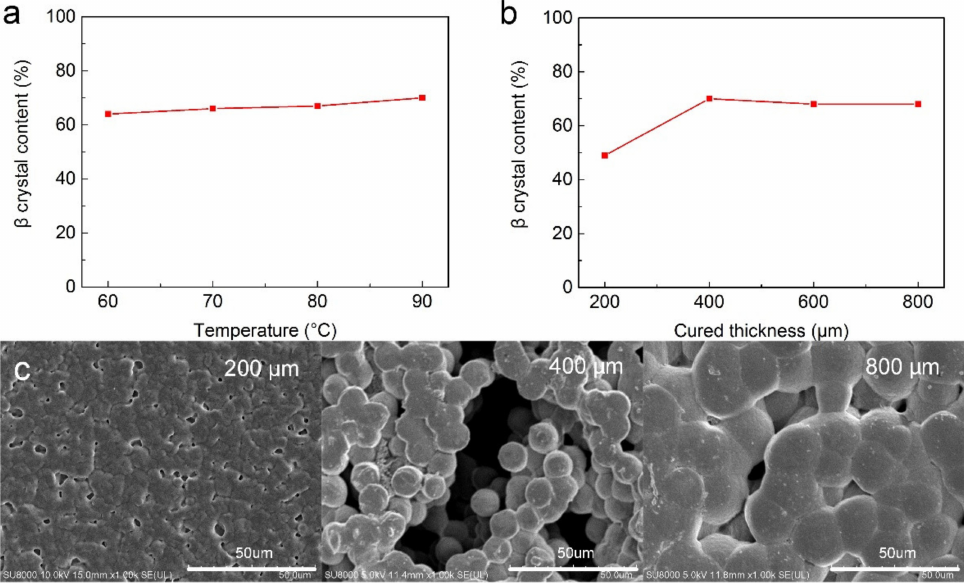
Figure 5. Polarization parameters of PVDF: β crystal content as a function of ( a ) temperature, ( b ) curing thickness, and ( c ) SEM images of PVDF layers with thicknesses of 200, 400 and 800 µ m.